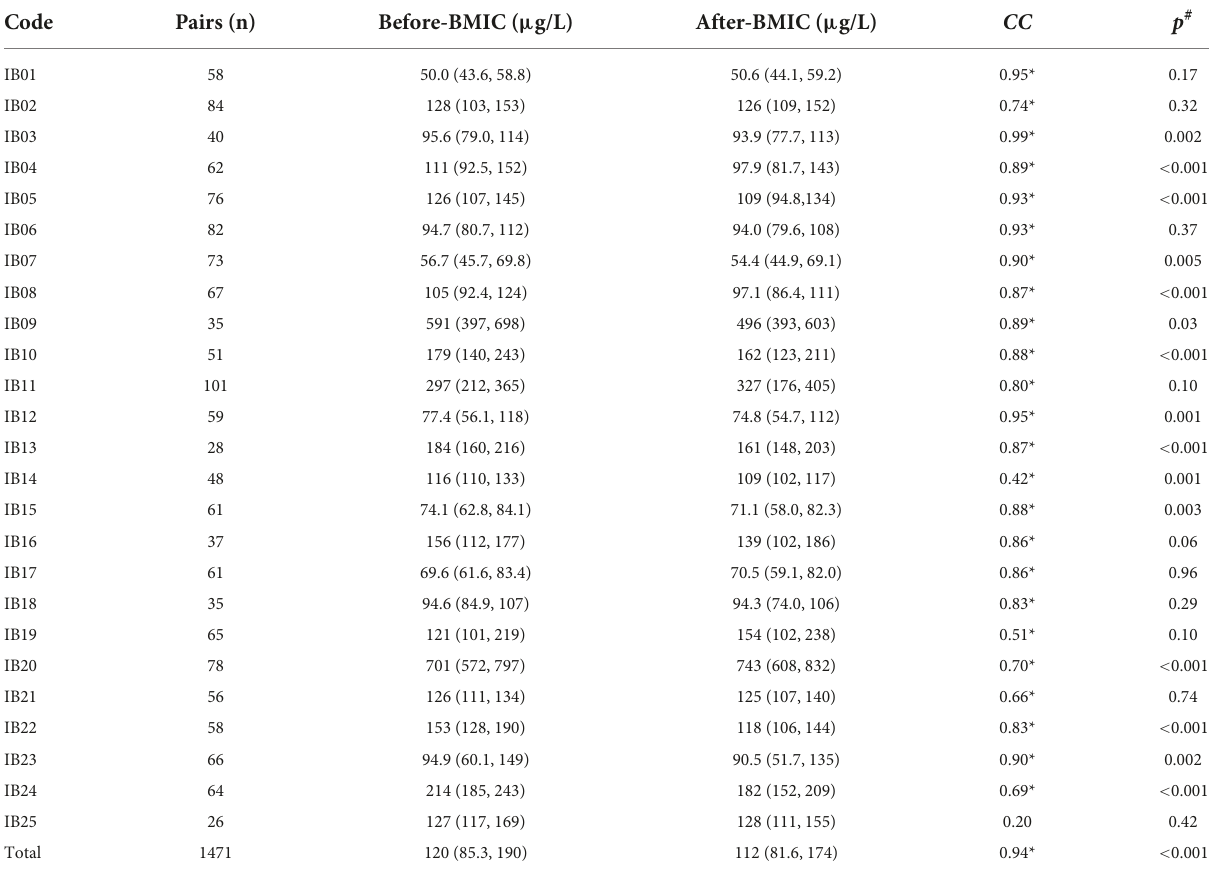
TABLE 2 Difference and correlation of breast milk iodine concentration (BMIC) before and after lactation. Code Pairs (n) Before-BMIC ( µ g/L) After-BMIC ( µ g/L) CC